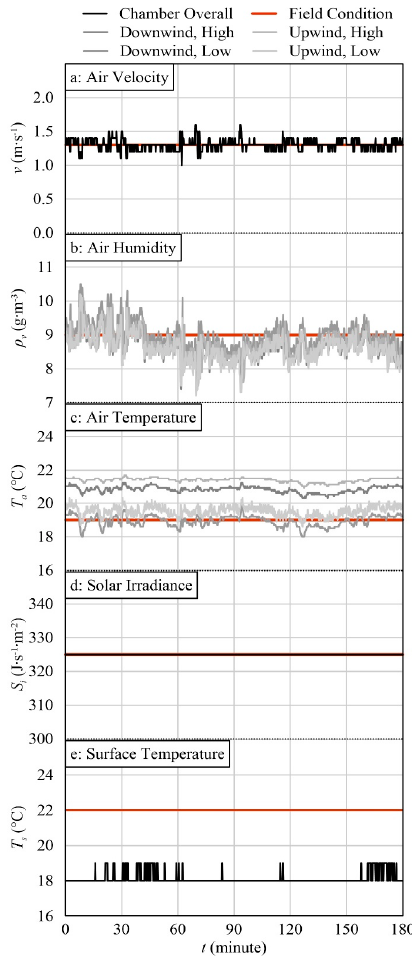
Figure 5. Typical atmospheric and water surface condition in the BAS for a summer day: ( a ) air velocity, ( b ) air humidity, ( c ) air temperature, ( d ) solar irradiance, and ( e ) surface temperature. Table 3 gives a summary of the analysed data of average atmospheric and water sur- face parameters for the investigated weather scenarios. The corresponding transient data (not given in this paper) were found to be steady. From a momentum perspective, the aerodynamic resistance is a pertinent parameter affecting evaporation in the BAS. This parameter captures the atmospheric turbulent diffusion of mass and energy and is in- versely related to wind velocity and cover height [5]. The values of aerodynamic re- sistance were found to range from 41 s ∙ m − 1 to 47 s ∙ m − 1 (typical for water surfaces) such that the lower values in spring and fall were associated with high wind velocity and the re- verse was true for summer.